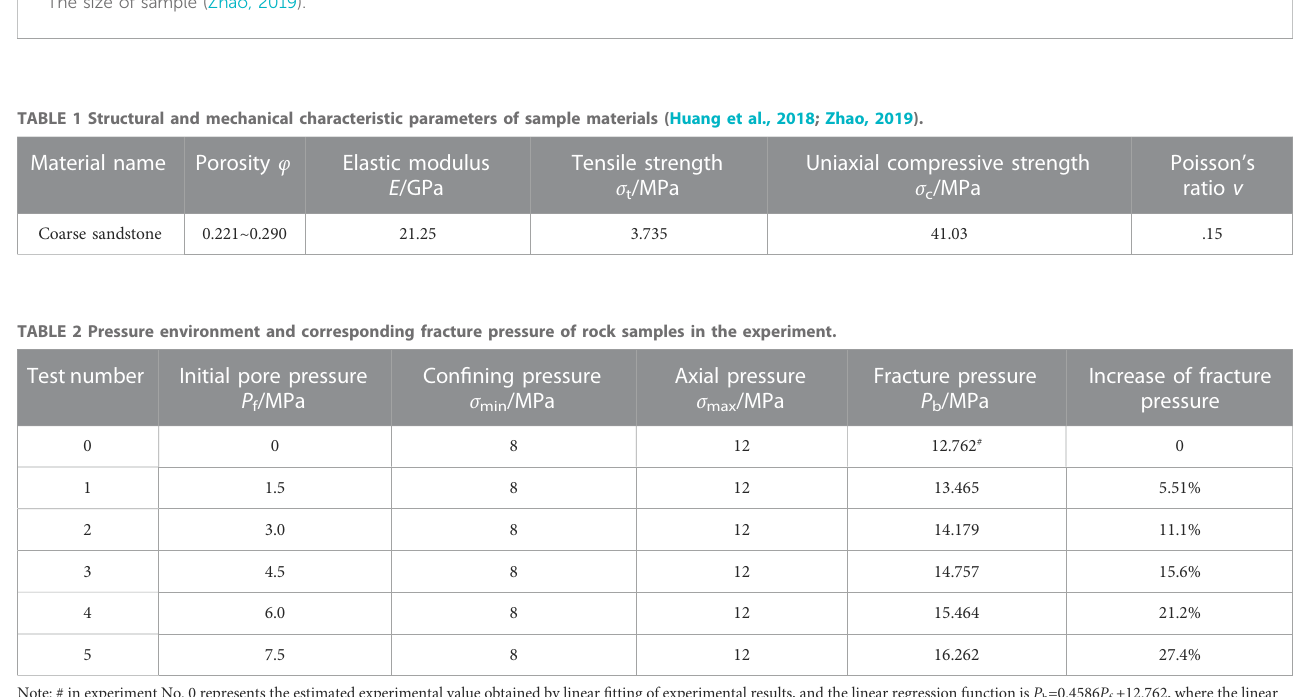
FIGURE 7 The size of sample (Zhao, 2019).